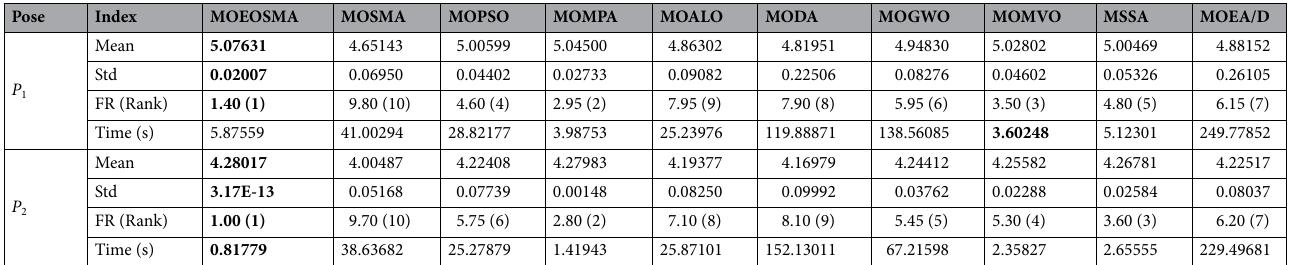
Table 8. HV results of multi-objective algorithms on two desired poses. The optimal values are shown in bold, and FR stands for Friedman’s